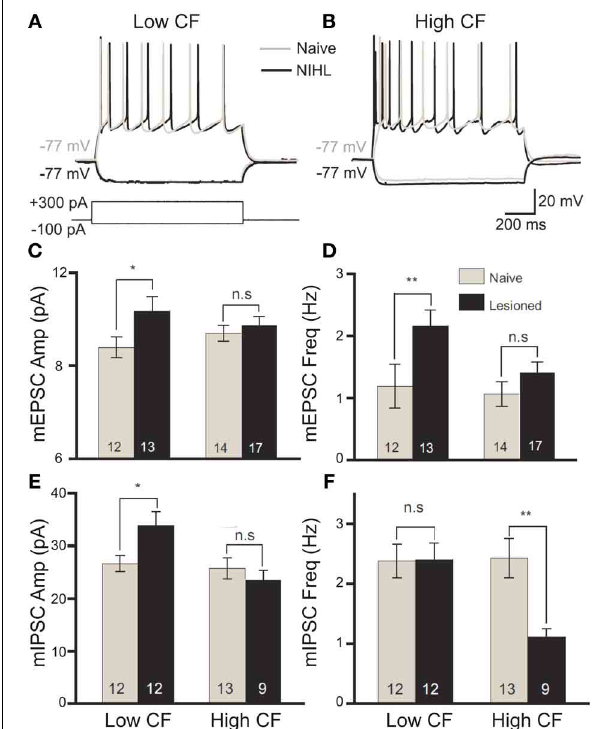
FIGURE 4 | The balance of excitation and inhibition is differentially modified by band-limited acoustic trauma according to the frequency tuning of cortical neurons. Following acoustic trauma (123dB SPL, 4kHz, 7h) of adult rats, in vitro patch recordings from primary auditory cortex layer II/III pyramidal neurons were performed to evaluate relative changes in excitability between neurons with low- or high-categorized characteristic frequency tuning. In response to square current pulse injection, low-CF neurons showed no enhancement in the number of spikes fired (A) , whereas high-CF cells displayed significantly elevated excitability (B) . Modified with permission from Yang et al. (2012). On recording miniature excitatory postsynaptic potentials (mEPSCs), there was a significant increase in the amplitude (C) and frequency (D) of mEPSCs in low-CF neurons only following trauma. Similar analysis of miniature inhibitory postsynaptic potentials (mIPSCs) revealed a significant trauma-driven elevation of mIPSC amplitude in low-CF neurons (E) , while the frequency of mIPSCs was significantly depressed in high-CF cells (F) . Modified with permission from Yang et al. (2011). ∗ p ≤ 0 . 05; ∗∗ p ≤ 0 .